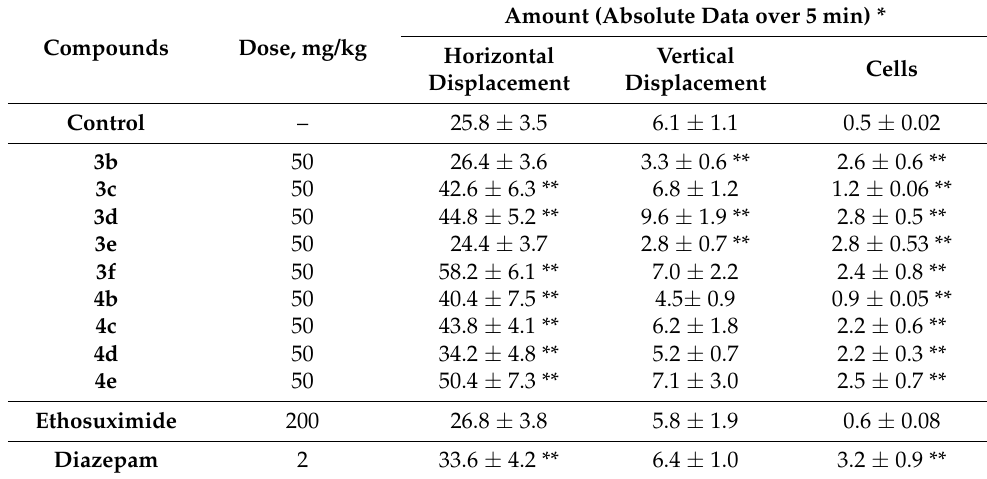
Table 4. Effect of compounds ( 3b , 3c , 3d , 3e , 3f , 4b , 4c , 4d and 4e ) in rats in the ”open field” test.